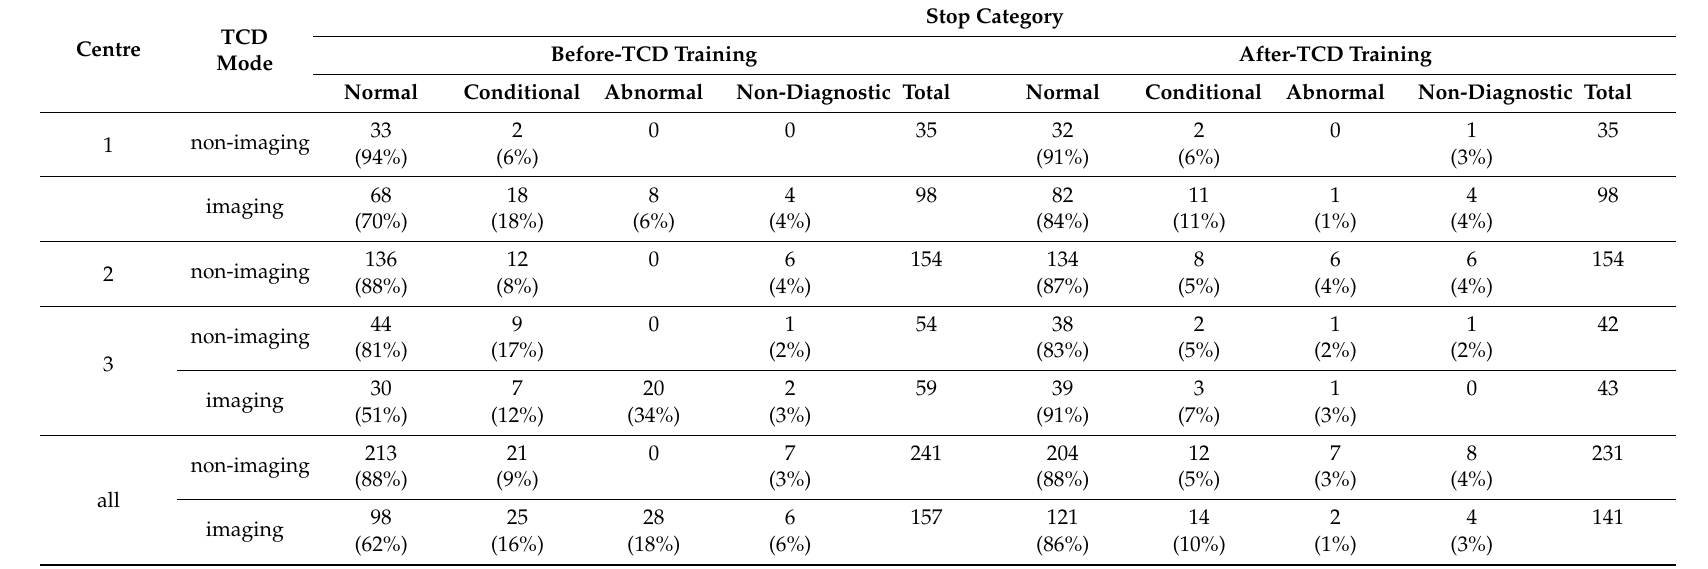
Table 3. Distribution of STOP categories with respect to Centre and TCD mode, before and after TCD